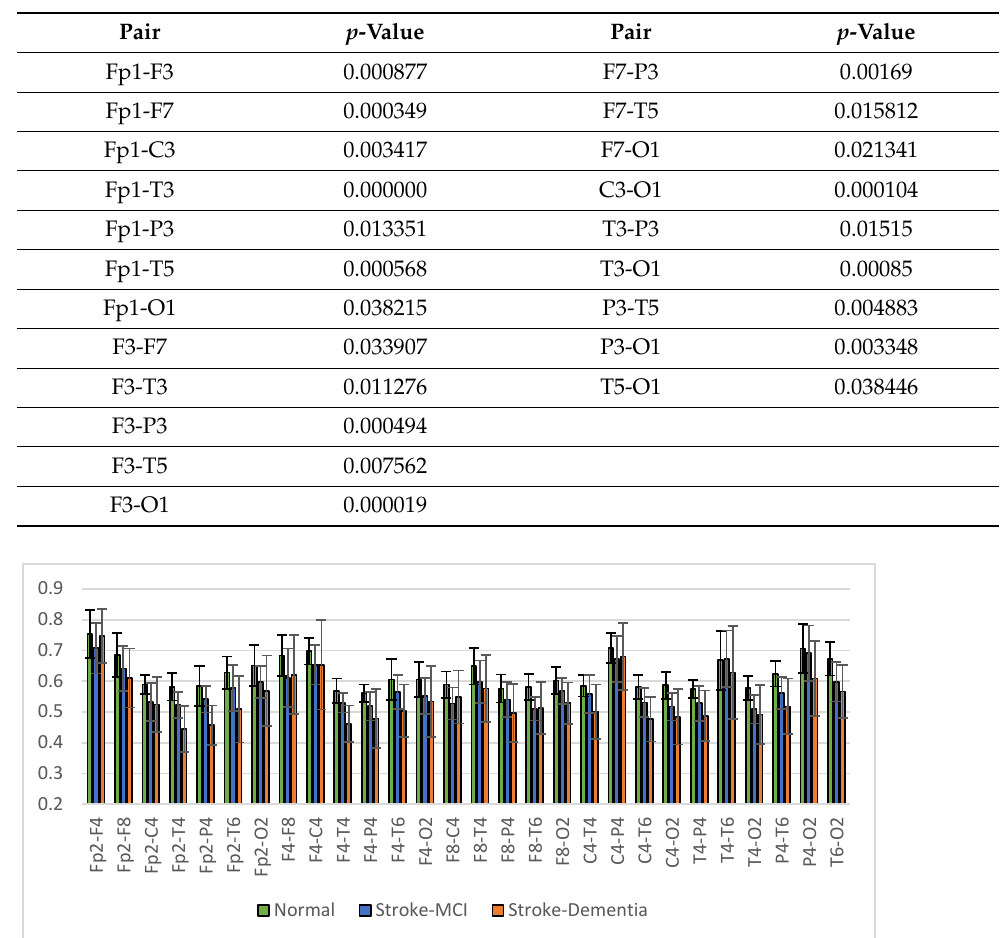
Table 7. The left intrahemispheric coherence value resulted in p < 0.05.